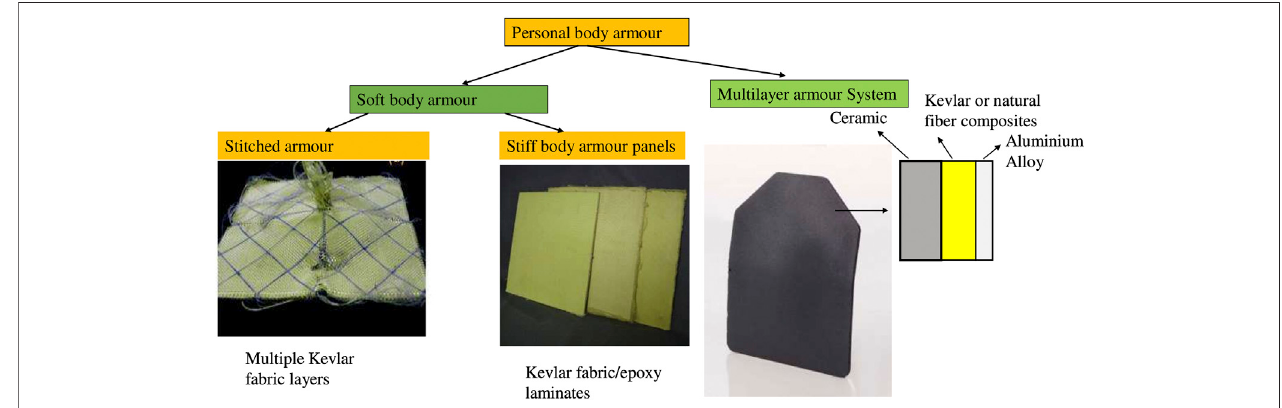
FIGURE 1 | Classi fi cation of body armour system. Roy et al.